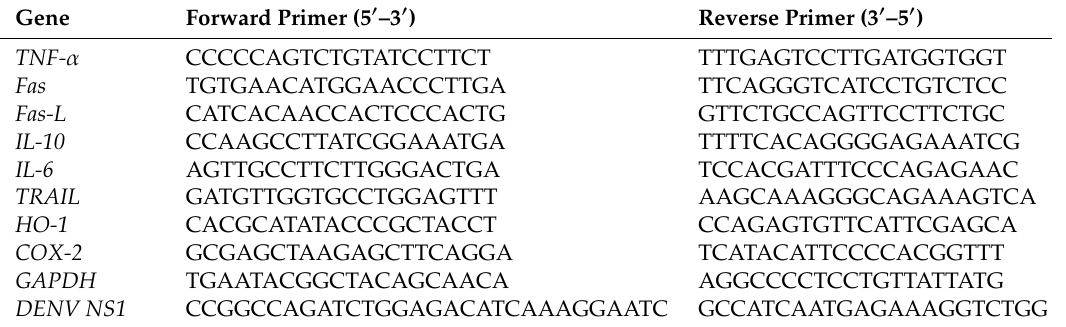
Table 1. The primer designs used for the RT-PCR